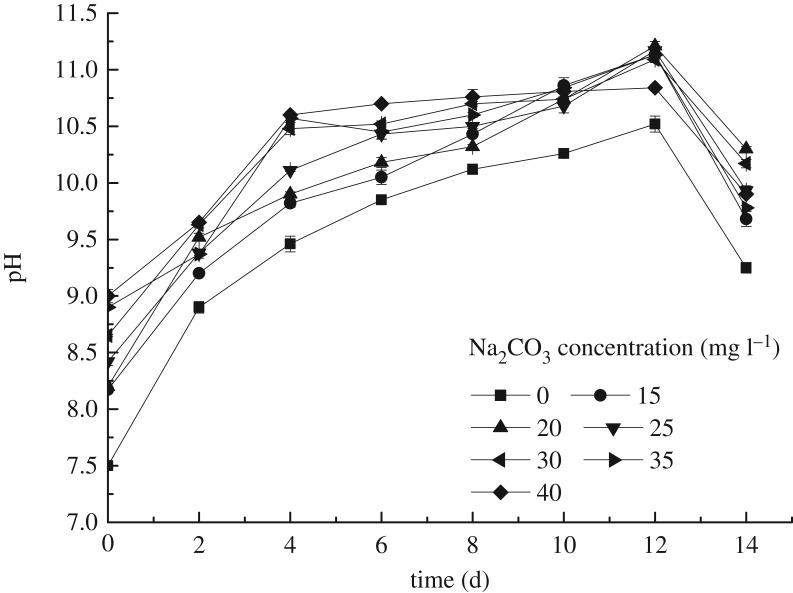
The pH changes of the microalgae liquid under the different Na2CO3 concentrations.